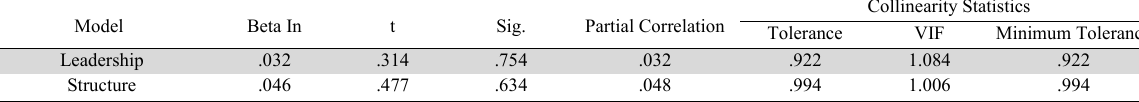
The results when the variable is excluded for from EP=f(L, T, S)